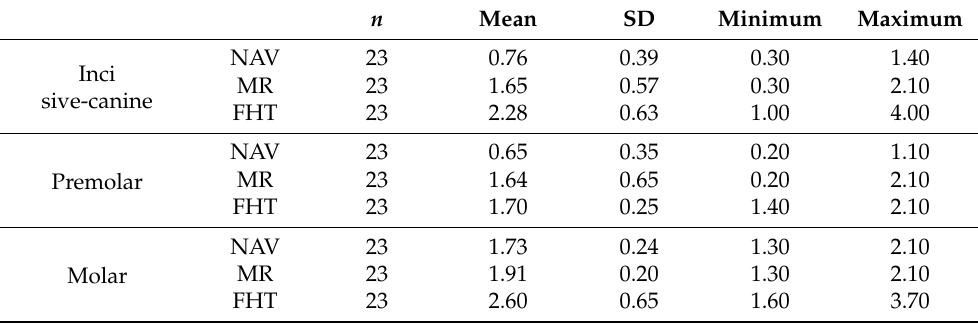
Table 2. Descriptive deviation values at coronal entry-point (mm) of the orthodontic micro-screws placed by using conventional freehand technique, mixed reality technique and computer-aided static navigation technique study groups in the incisive-canine, premolar and molar dental sector.